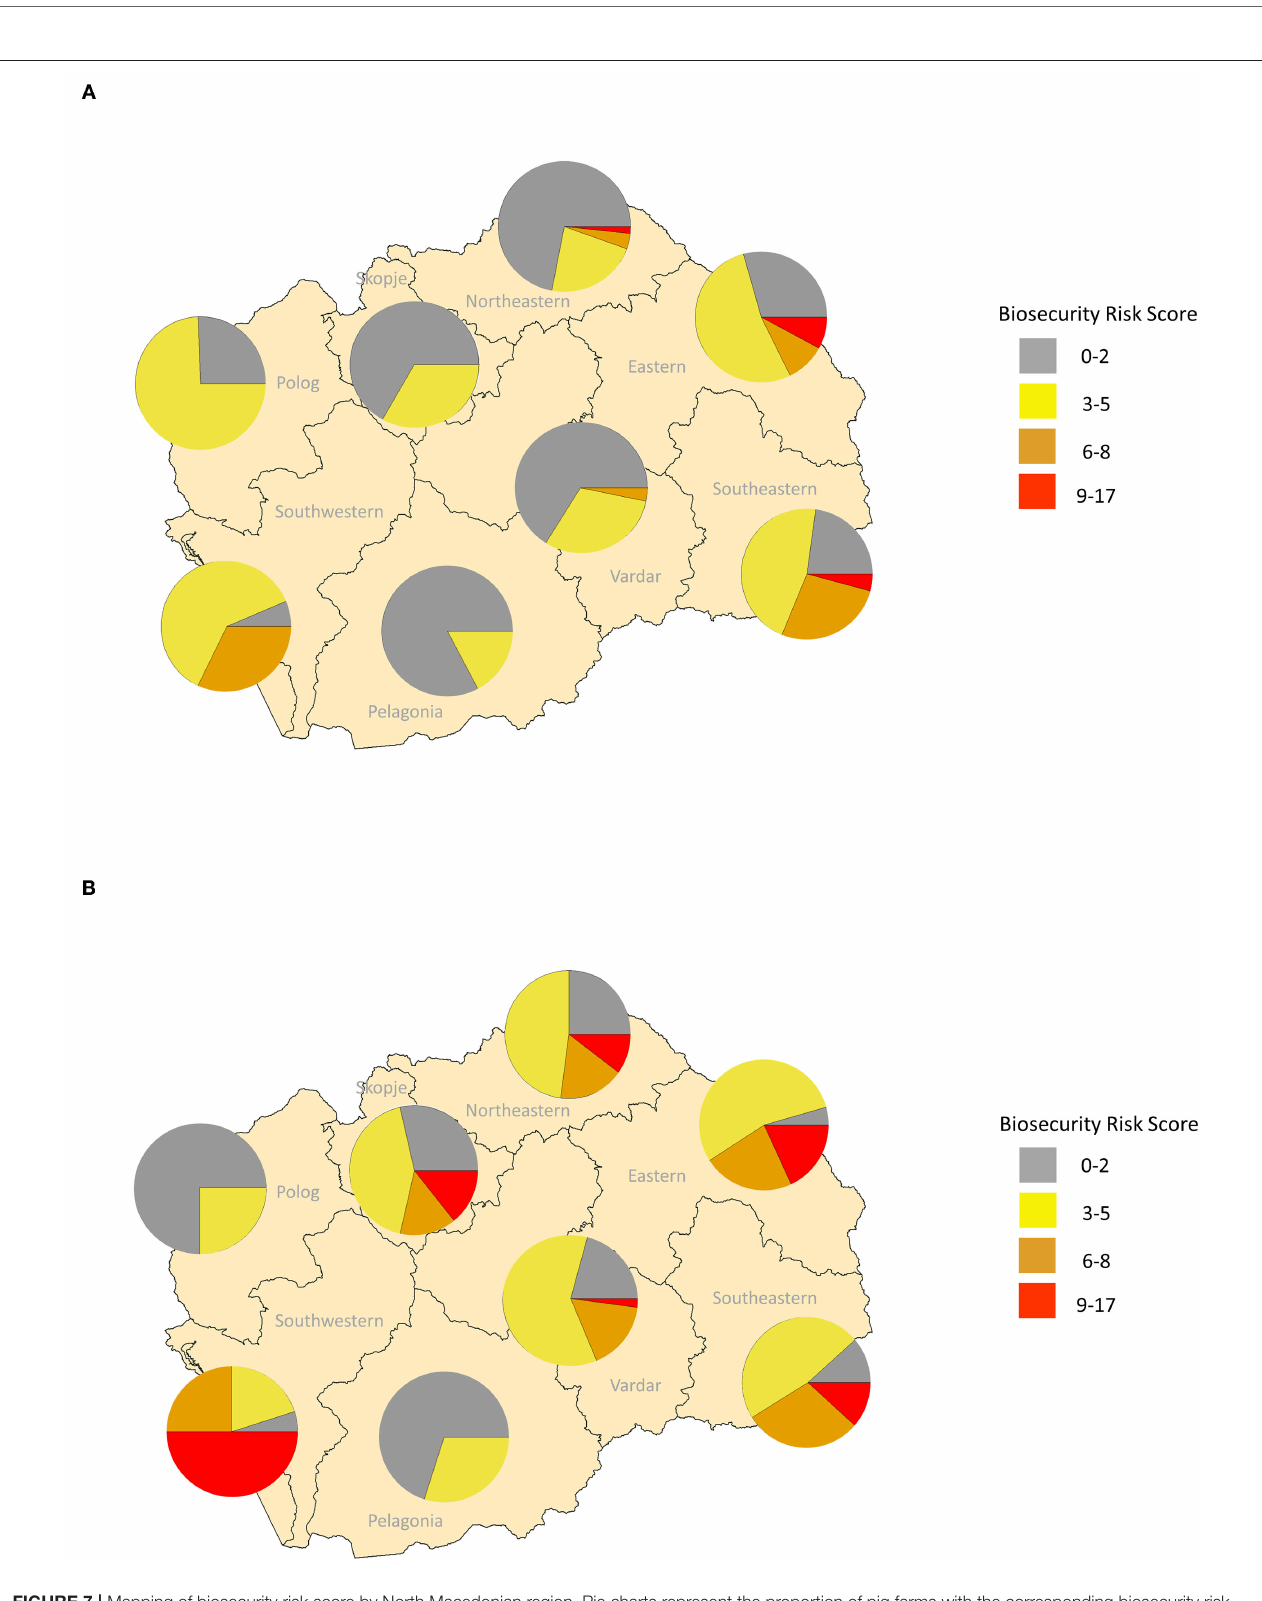
Frontiers in Veterinary Science |